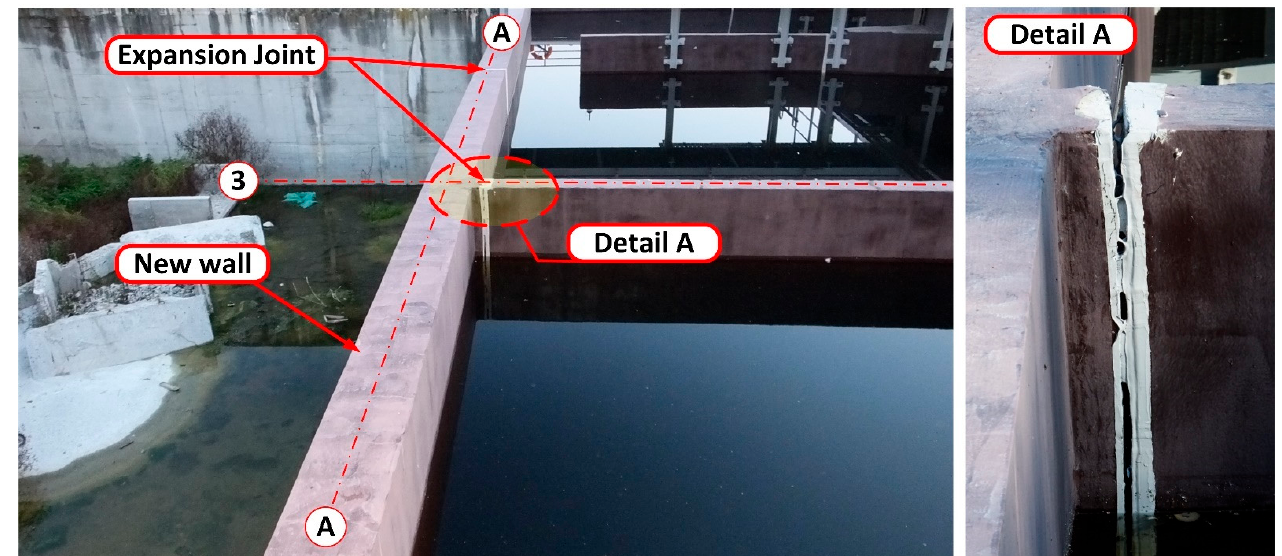
Figure 5. Leak testing of the biological reactor. View of the wall on the A/1–5 axis. Failure of the expansion joint at the interface between the vertical wall on axis 3 is visible. The first 12 h of leak testing.